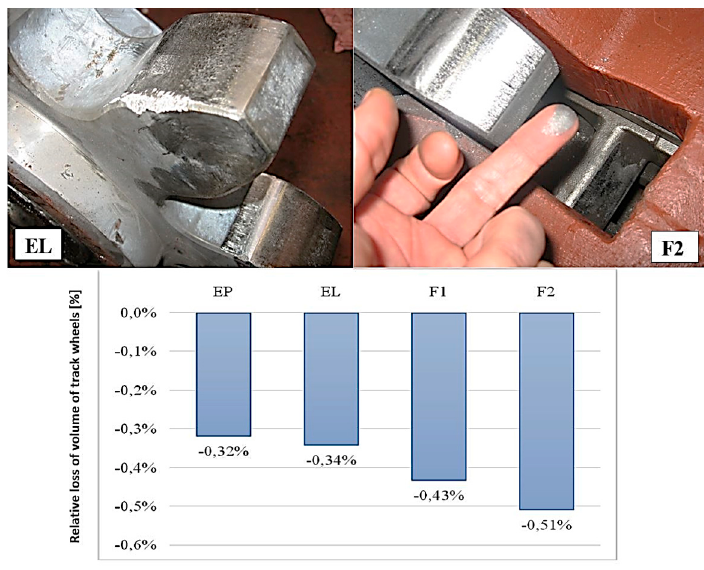
Figure 5. View of track wheel wear and graph of the relative volume loss of individual track wheels: EP and EL—right and left track wheel in the Eicotrack system, F1 and F2—right and left track wheel in the Flextrack system.